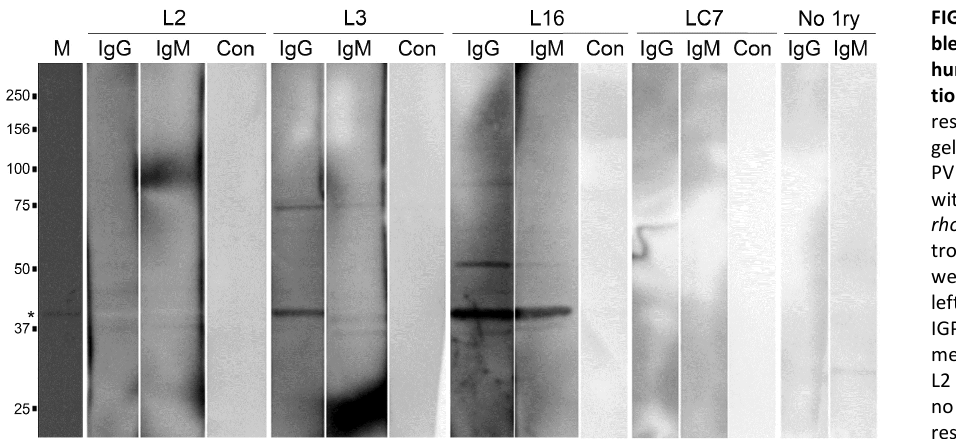
respectively. Lanes 5, 6 and 7: membrane probed with plasma Microbial Cell | October 2014 | Vol. 1 No. 10